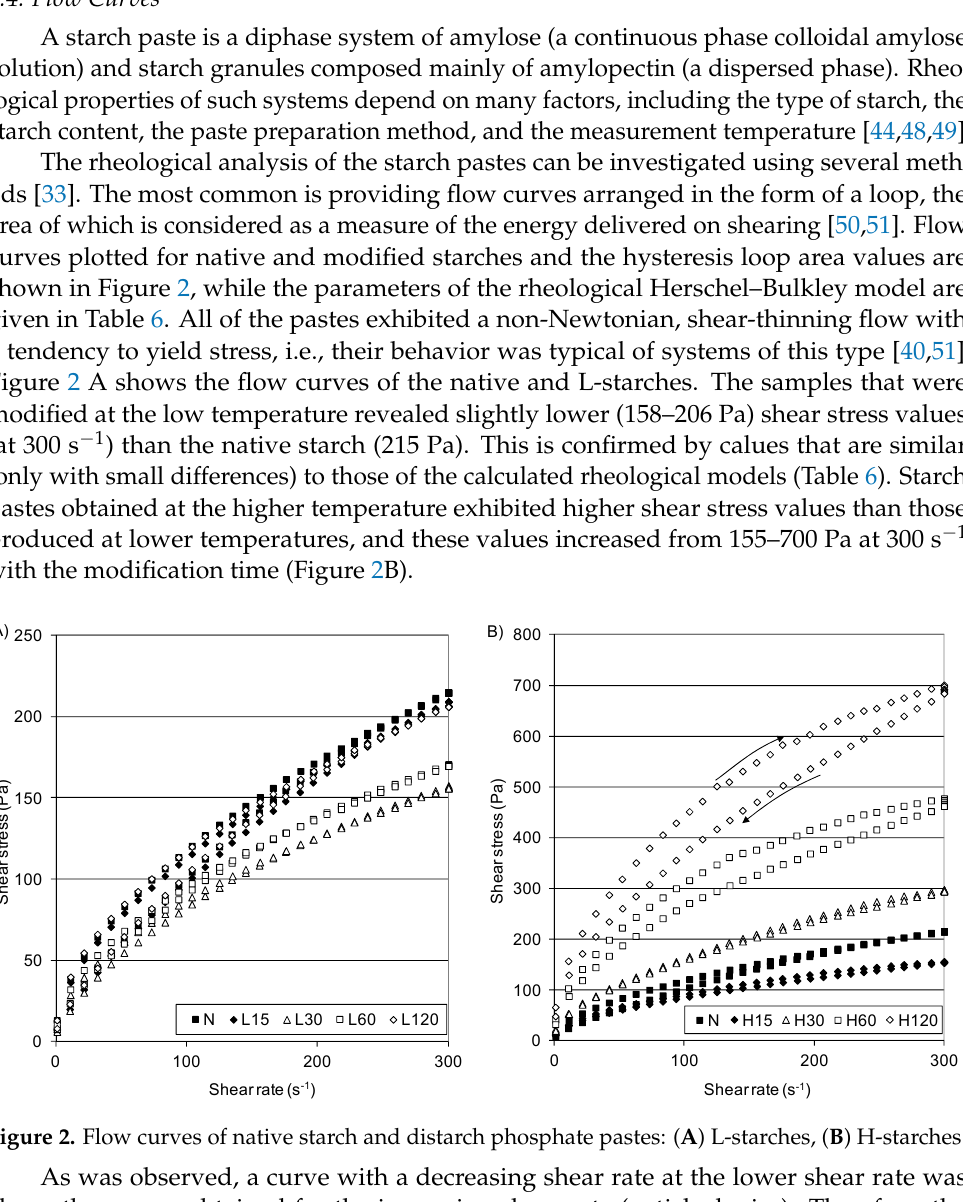
Table 6. Parameter of the Herschel–Bulkley model describing flow curves of native starch and distarch phosphate pastes and recovery.